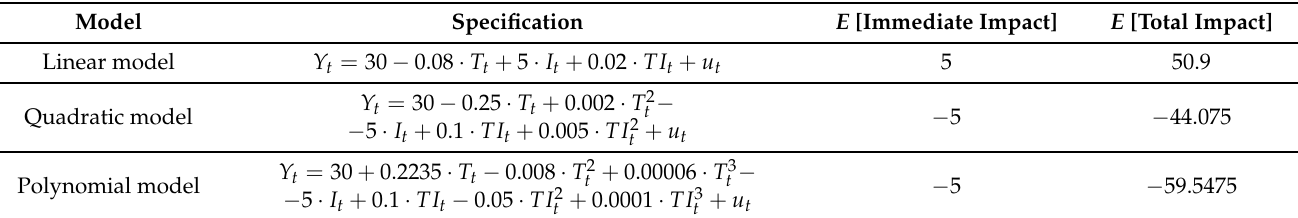
Table 1. Data generation.